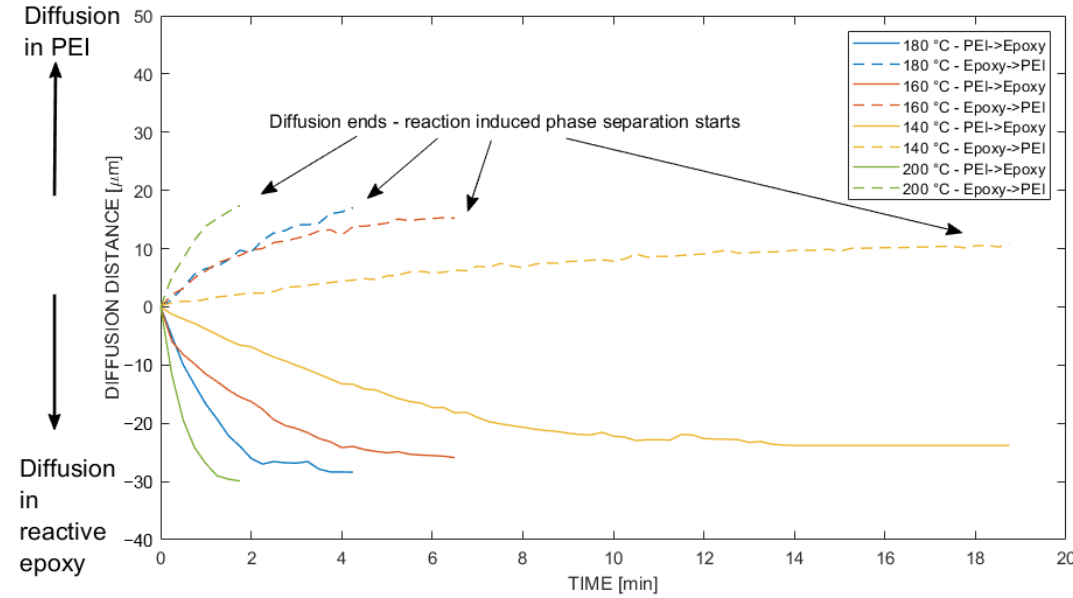
Figure 7. Diffusivity of reactive multicomponent diffusion experiments on an optical hot stage setup derived by the point tracker algorithm. Values in the positive direction indicate diffusion from the epoxy system into PEI, whereas values in the negative direction indicate diffusion from PEI into the epoxy system. Table 2. Overview of important values derived from reactive multicomponent diffusion